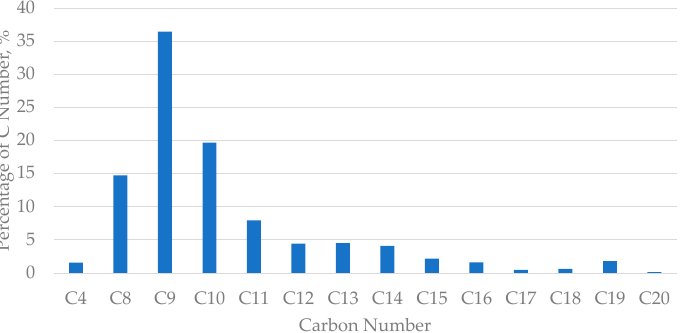
Figure 2. Percentage of the number of carbons present in condensate sourced from PETRONAS, Kerteh, Malaysia.